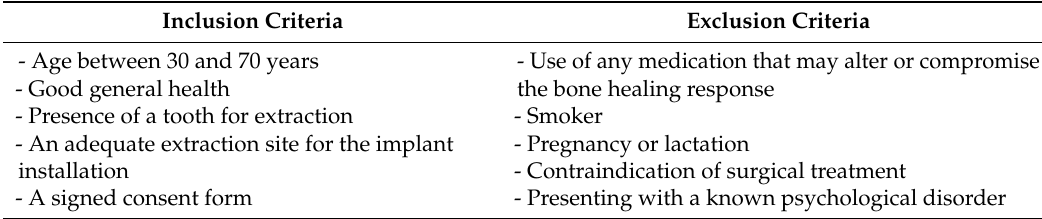
Table 3. Inclusion and exclusion